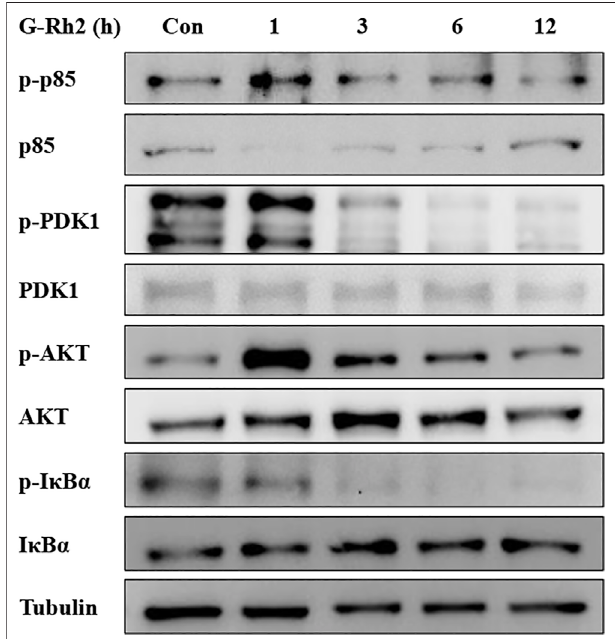
FIGURE 9 | Effects of G-Rh2 on apoptosis-related proteins and their phosphorylation levels in A549cells. Cells were treated withG-Rh2 for 0, 1, 3, 6, and 12 h. The protein levels of p85/p-p85, PDK1/p-PDK1, Akt/p-Akt and I κ Ba/p-I κ Ba were measured by Western